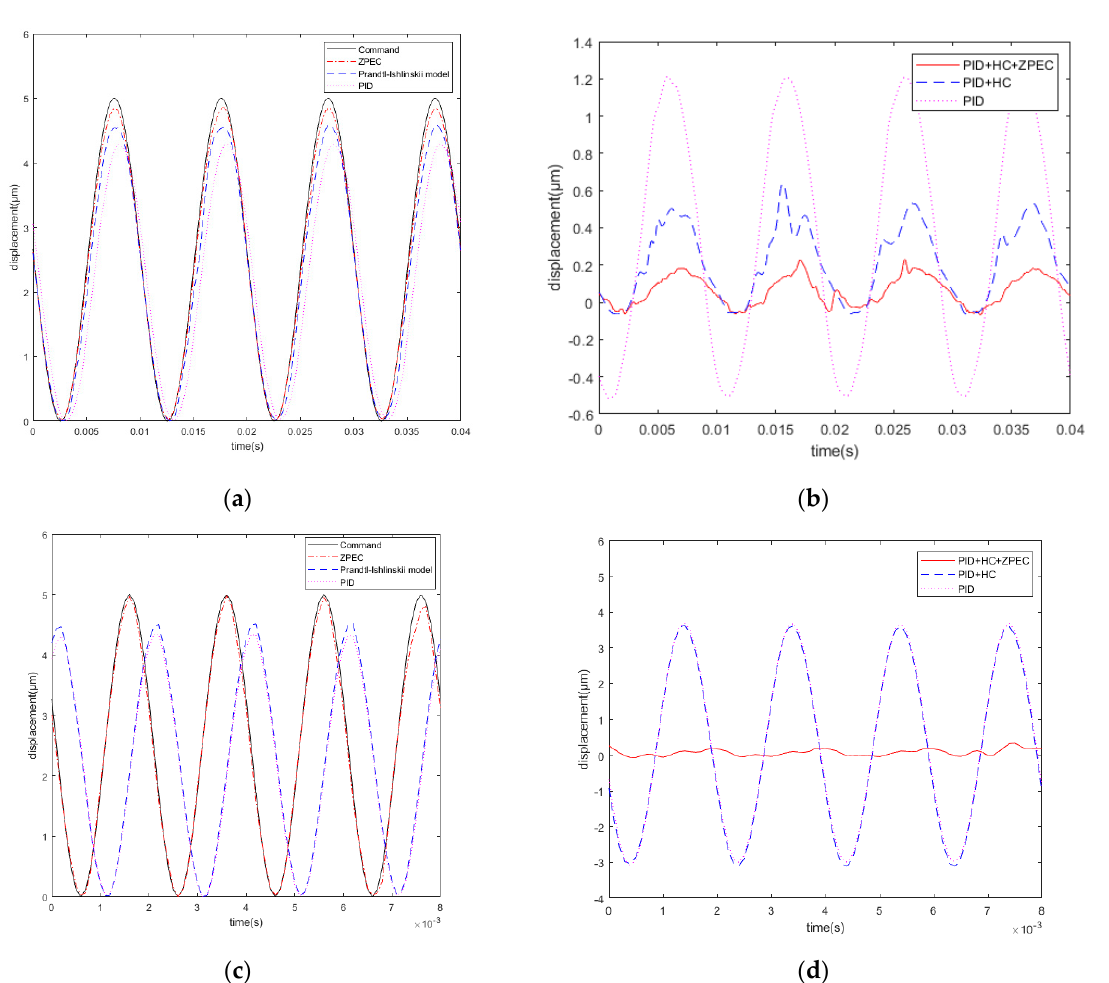
Figure 13. ( a ) Sinusoidal signal at 100 Hz; ( b ) tracking errors of the 100 Hz sinusoidal signal; ( c ) 500 Hz sinusoidal signal; ( d ) tracking errors of the 500 Hz sinusoidal signal.